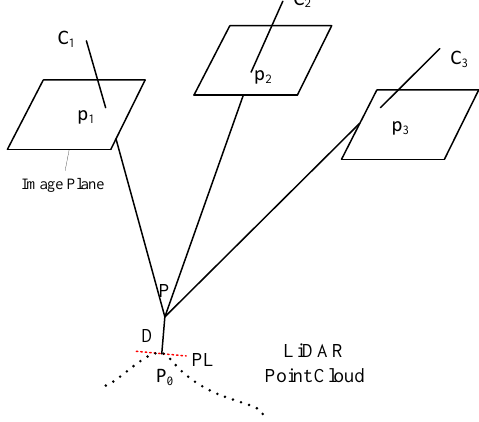
Figure 3. The geolocation between LiDAR and images.